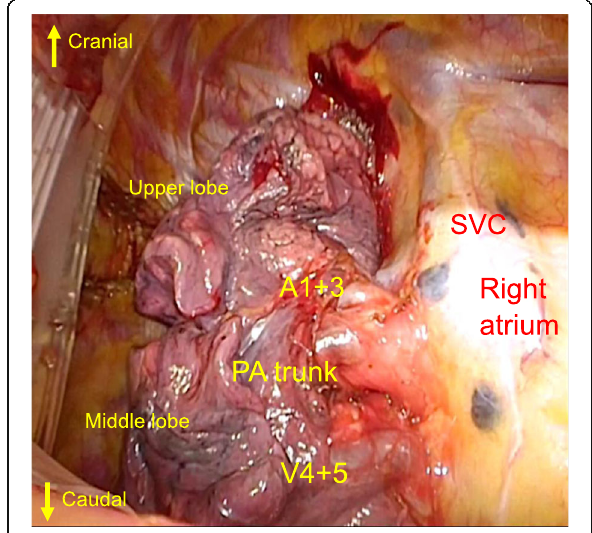
Fig. 3 From the operation forward view, the segmental vein V1 and vein V2+3 cannot be seen in the usual pulmonary hilum position. Instead, the main pulmonary artery runs in front of the